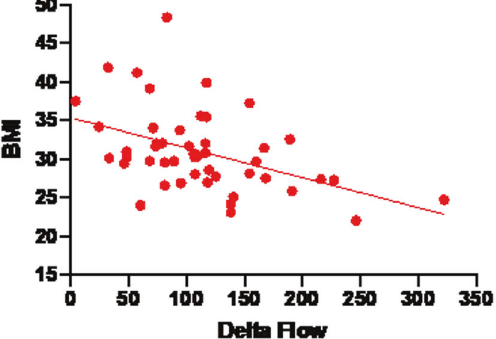
Fig. 2 Correlation of delta fl ow and body mass index (BMI). This correlation increases with time and is stronger at time-6-months ( r =